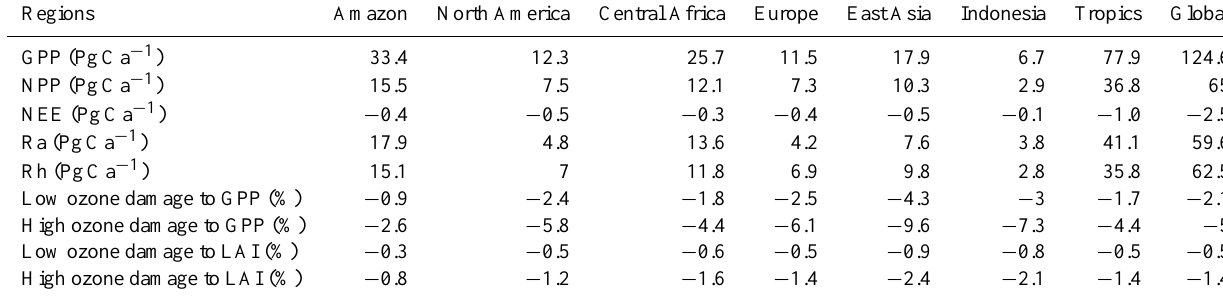
Table 3. Summary of carbon fluxes and ozone vegetation damage in different domains and for the tropics (23 ◦ S–23 ◦ N). Regions